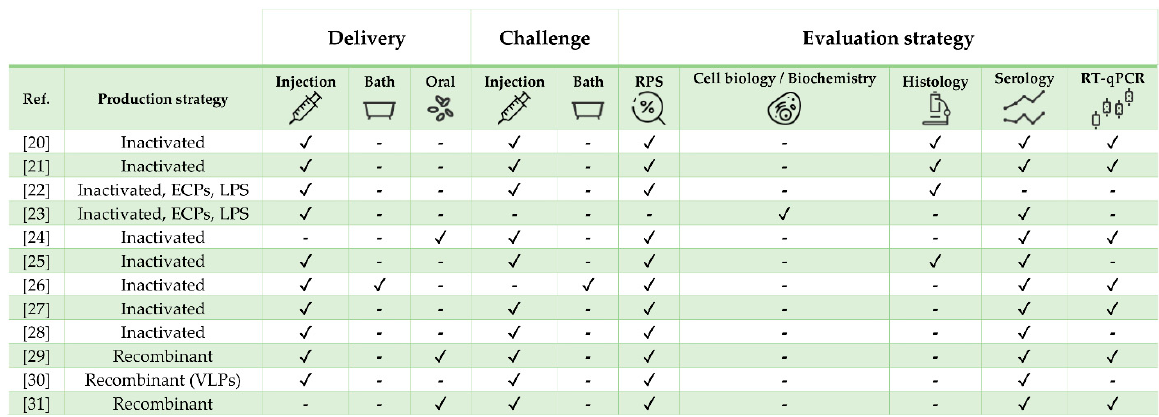
Figure 1. Strategies for vaccine development, administration, and evaluation applied by referenced studies on European sea bass Dicentrarchus labrax . Table 2. Literature regarding experimental and commercial vaccines herein presented and discussed for Nile tilapia Ore- ochromis niloticus . Approximate size refers to the fish BW at the time of challenge or RPS calculation, as stated in or inferred from references. In case of commercial vaccines, the product description was linked. Challenges must be intended as ho- mologous except when stated otherwise.